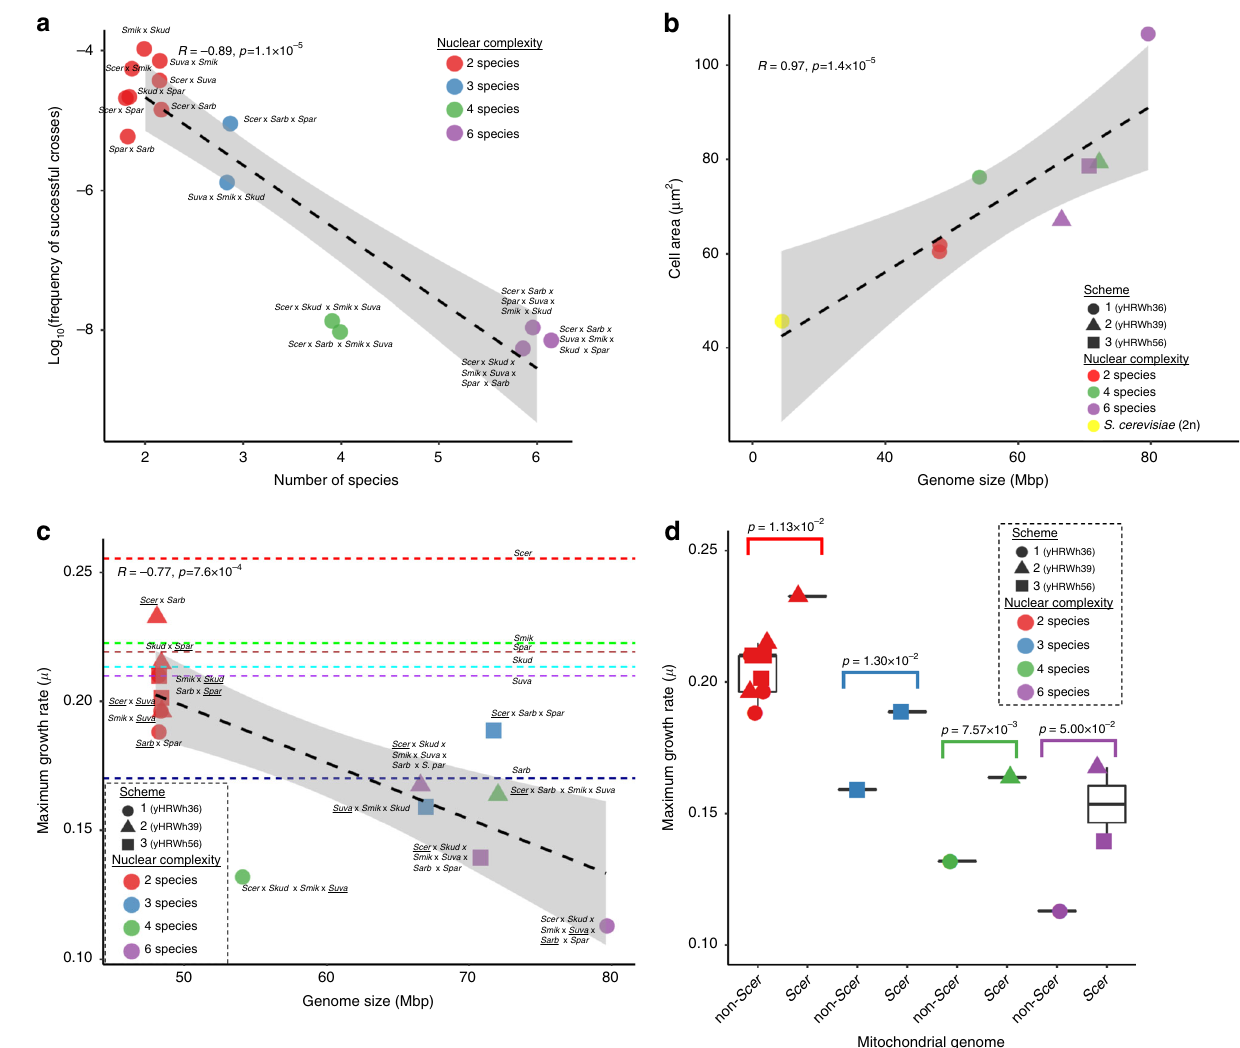
Fig. 3 Characteristics of six-species hybrids. a The number of species contributing genomes to synthetic hybrids is inversely correlated with the frequency of successful matings ( n = 2 cross attempts). b Genome size is correlated with average cell area (average n = 63 counted cells). c Genome size (Supplementary Data 2) versus the average maximum growth rate ( µ ( n = 6 independent biological replicates), de fi ned as (ln( OD2 ) − ln( OD1 ))/( T2 – T1 )) in rich medium at 20 °C (Supplementary Data 4). Dashed lines are the µ for the parent species indicated close to the line. For S. uvarum , the average of two strains with different HyPr plasmids is shown. d The maximum speci fi c growth rate ( µ , de fi ned as (ln( OD2 ) − ln( OD1 ))/( T2 − T1 ))) in rich medium at 20 °C is higher in interspecies hybrids inheriting S. cerevisiae mtDNA. Median values are represented by a horizontal line inside the box, and the upper and lower whiskers represent the highest and lowest values of the 1.5 × IQR (interquartile range), respectively. Colors correspond to the number of species contributing genomes to each strain. Synthetic hybrids generated from independent schemes are represented by different shapes in panels b – d . The Spearman rank-sum test R and p values are displayed. A linear regression and its 95% con fi dence interval are represented with a black dashed line and gray shadow, respectively. The mtDNA donor is underlined in the names in panel c . Species composition abbreviations are Scer , S. cerevisiae ; Spar , S. paradoxus ;